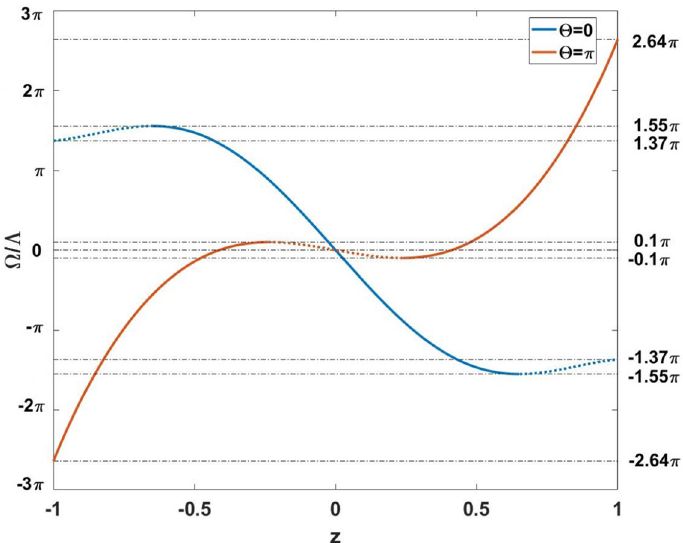
Figure 2. Normalized frequency spacing �/� (dashed lines) versus reduced population imbalance z for Eq. (26) (blue line) and Eq. (27) (red line), respectively. Dashed regions correspond to unstable solutions.